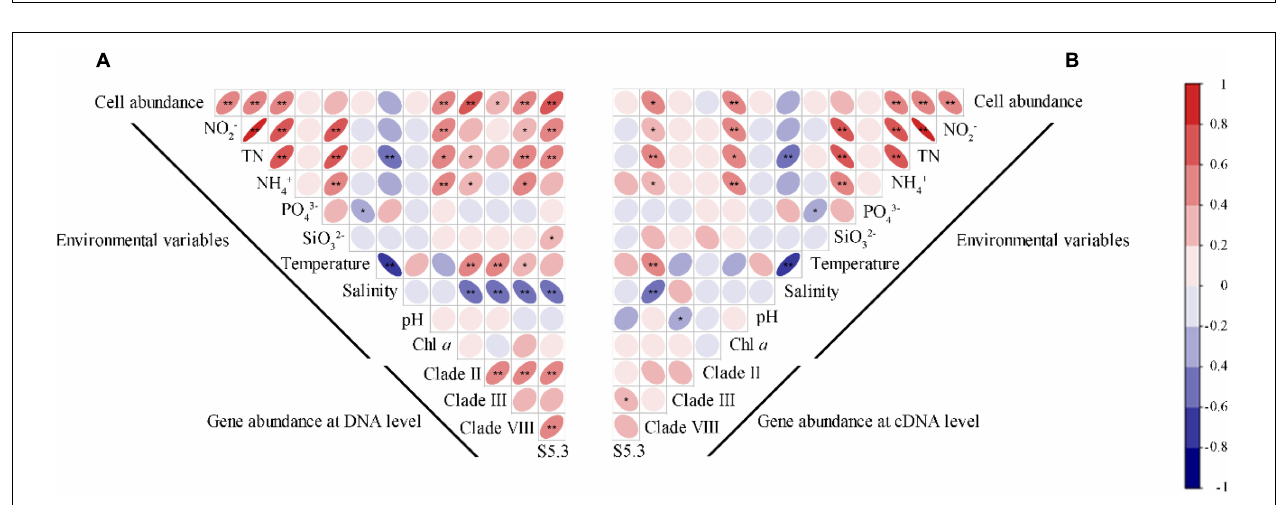
FIGURE 4 | (A) LEfSe analysis showing the Linear Discriminant Analysis (LDA) score between DNA and cDNA levels. (B) LEfSe analysis showing the LDA score among stations and between seasons at the DNA level.